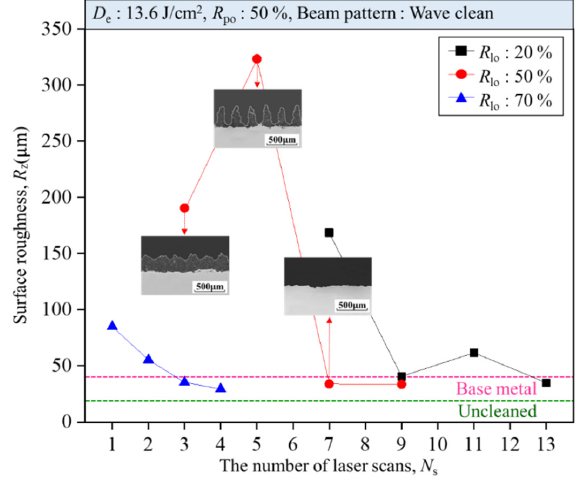
Figure 10. Variation of roughness in the laser-cleaned surfaces according to the line overlap rates.